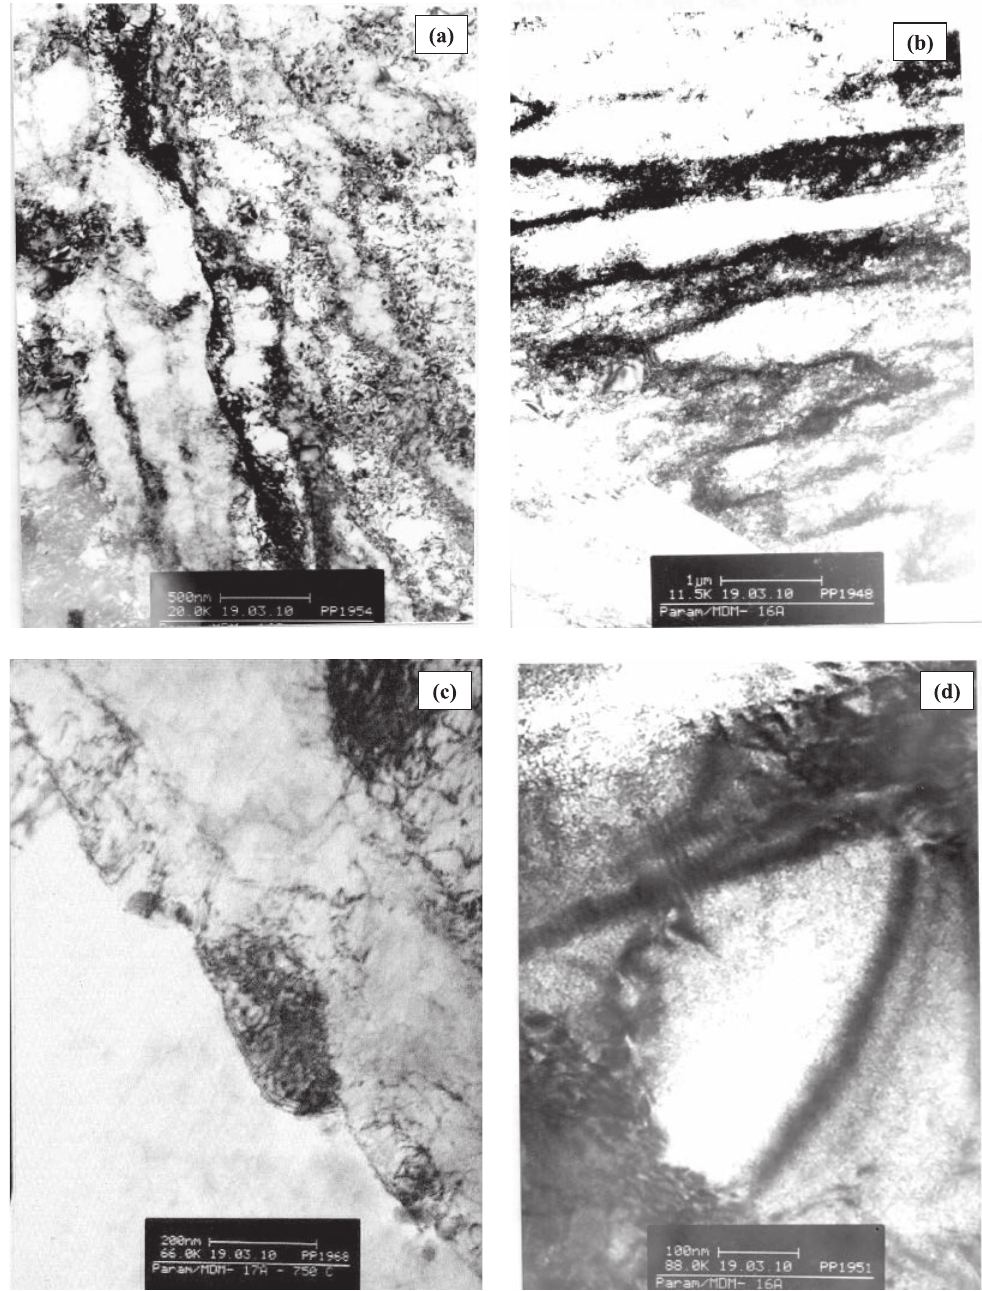
Fig. 8: TEM micrographs of ESR grade alloy D9 stainless steel (a) tested at 1073 K, depicting defect dominated elongated cells (b) tested at 1073 K, showing wavy nature of grain boundaries (c) tested at 1023 K, showing formation of subgrain boundaries along wavy grain boundary, and (d) tested at 1073 K, depicting fine recrystallized grains with moire fringes along its